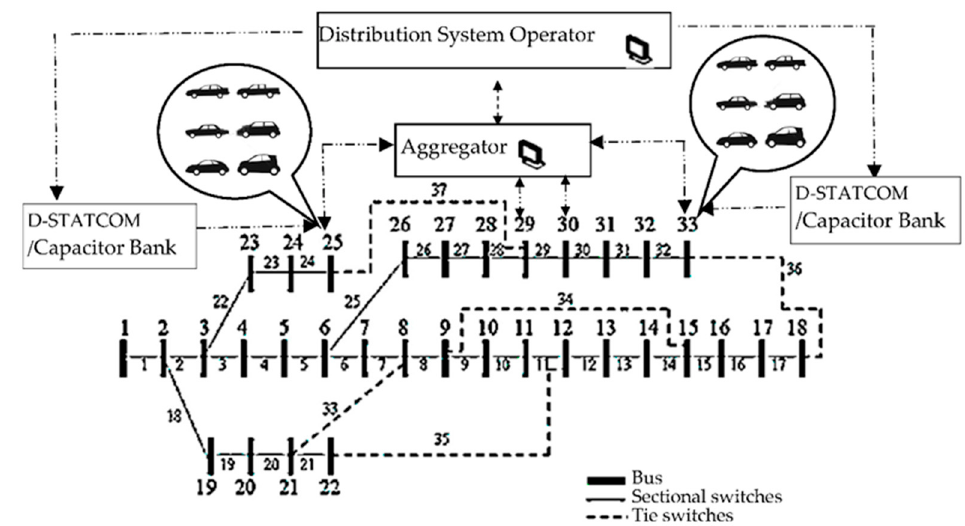
Figure 1. IEEE 33 radial bus network with EV aggregator chargers, Distributed Operator (DSO) and reactive power compensators.